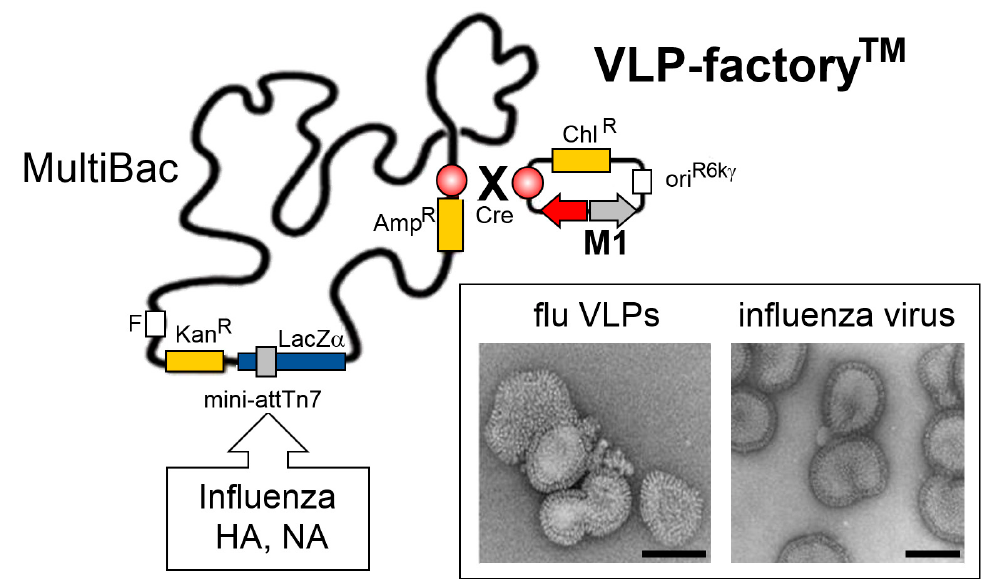
Figure 5. MultiBac-based VLP-factory TM . A plasmid module comprising expression cassettes for the capsid-forming influenza H1N1 M1 protein (colored in grey) and a fluorescent protein marker, mCherry (colored in red), was introduced into the MultiBac baculoviral genome by Cre recombinase enzyme mediated plasmid fusion into the LoxP site (circle filled in red, gradient) present on the viral backbone (top right). Genes encoding for hemagglutinin (HA) and neuraminidase (NA) from one or several influenza strains can be integrated into the Tn7 attachment site distal from LoxP. Co-expression of HA, NA and M1 yields synthetic influenza virus-like particles (VLPs) resembling live influenza virus as shown in electron micrographs (boxed) [78]. Scale bars, 100nm. Abbreviations as in Figure 1; ori R6K γ , conditional origin of replication; Chl, chloramphenicol.